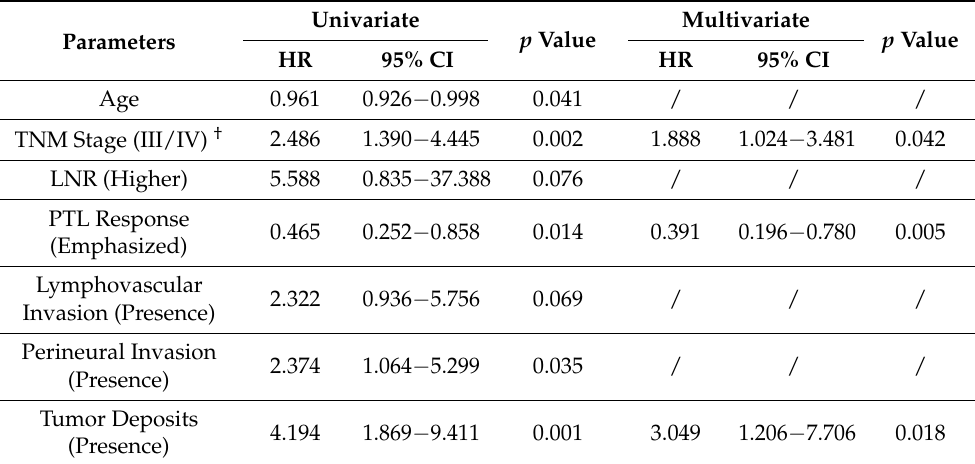
Figure 1. Kaplan–Meier curves for overall survival in patients grouped by: ( A )—grades of complications by Clavien–Dindo classification; ( B )—modified Glasgow prognostic score; ( C )—presence of tumor deposits.